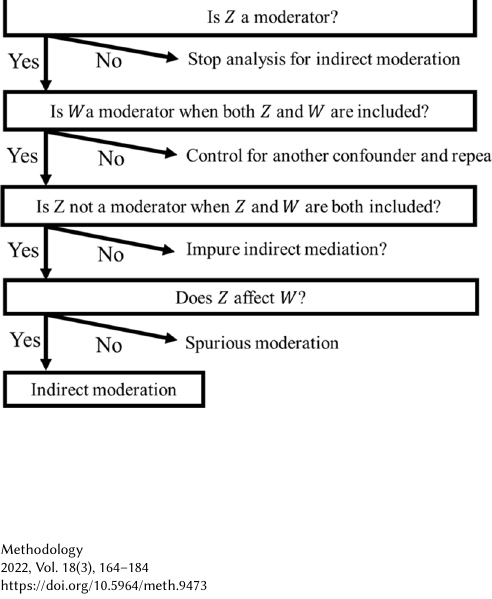
Methodology 2022, Vol. 18(3), 164–184